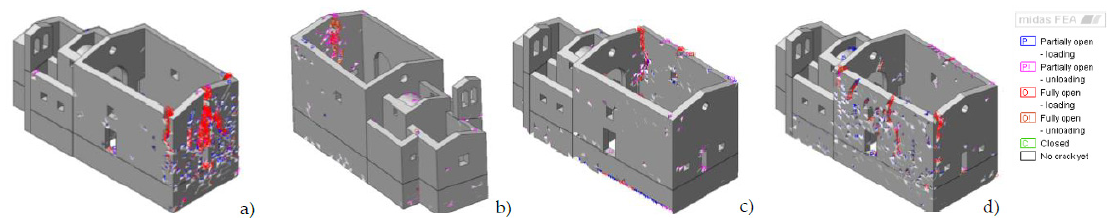
Figure 15. Numerical damage for Madonna of Valcora Sanctuary in Fiuminata (Macerata, Central Italy) for PushMass + x ( a ), PushMass − x ( b ), PushMass + y ( c ), PushMass − y ( d ).